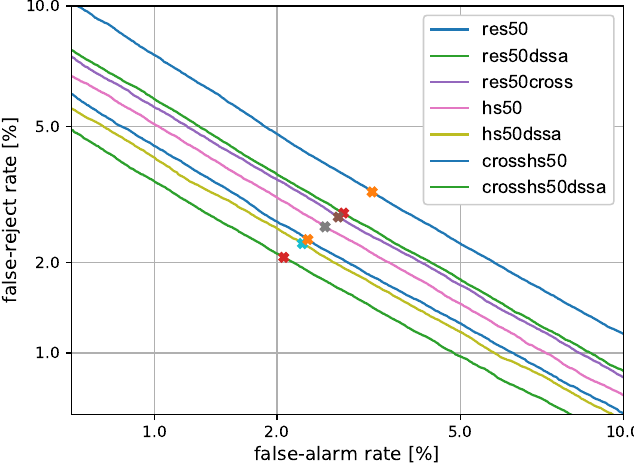
Figure 5. DET curves for all